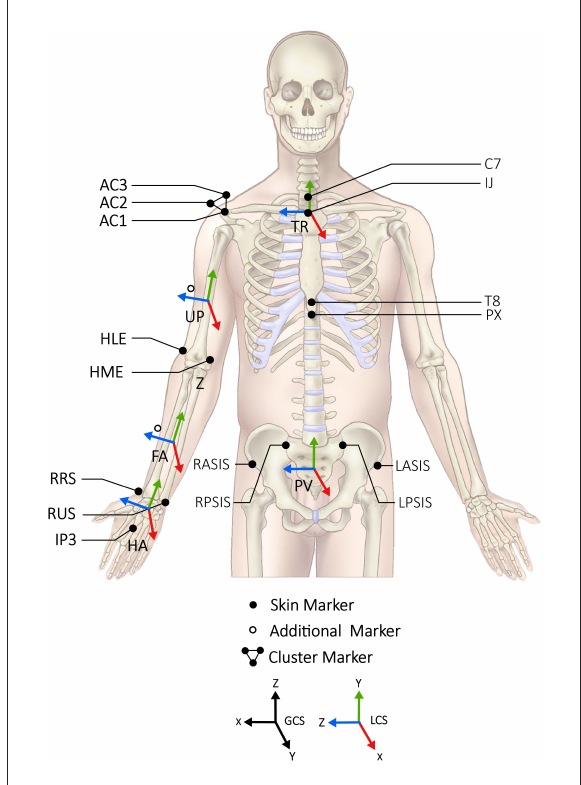
FIGURE1 The anatomical landmarks for the reflective markers, the local coordination systems of the pelvis (PV), trunk (TR), upperarm (UP), forearm (FA) and hand (HA) and the definition of the global coordination system are shown.